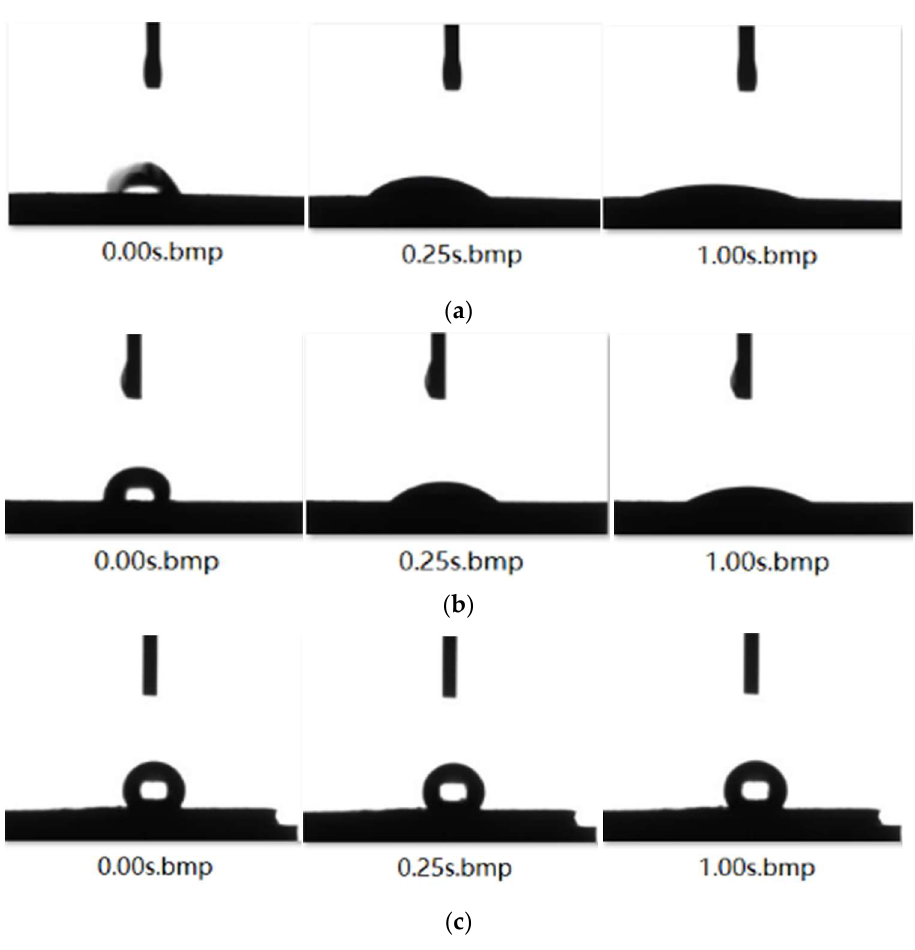
2 O and anthracite coal.